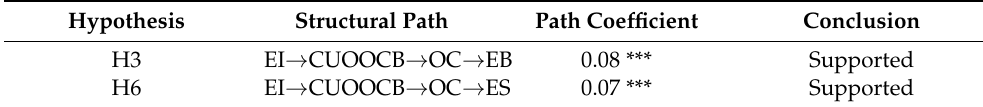
Table 7. Hypothesis testing and path coefficient (interactive